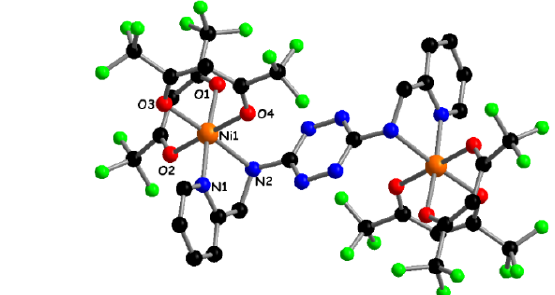
Figure 2. Anion– π interactions between TTZ and fluorine atoms (blue lines), and TTZ and oxygen atoms (red line) in 1 ( left ) and 2 ( right ). Hydrogen atoms were omitted for clarity.